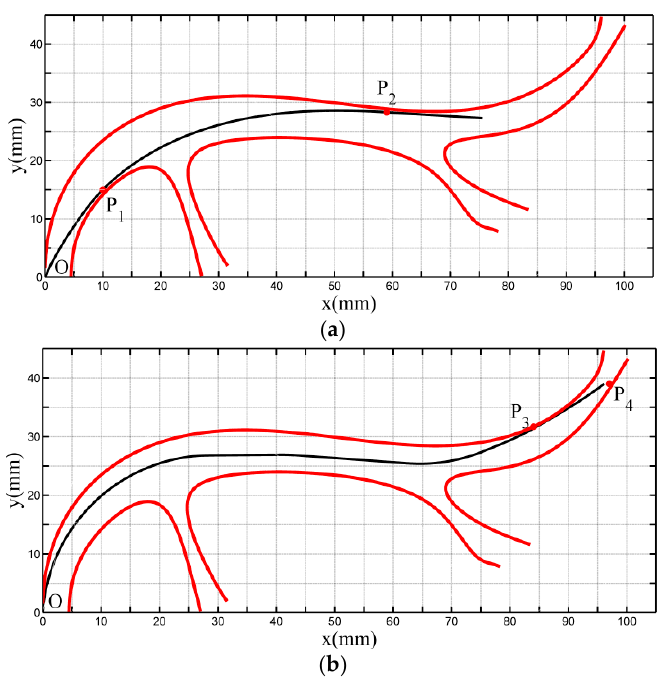
Figure 13. Deformed guidewire shape optimized via SQP in two positions: ( a ) Position I; ( b ) Position II.